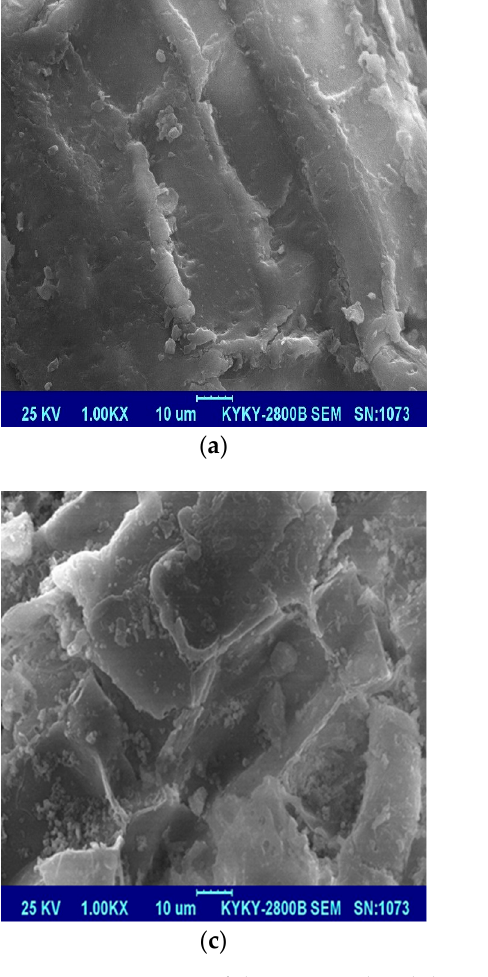
Figure 4. SEM images of the untreated and desugared reed roots before and after OTC adsorption. ( a ) R-U, ( b ) R-U OTC , ( c ) R-D, ( d ) R-D OTC .